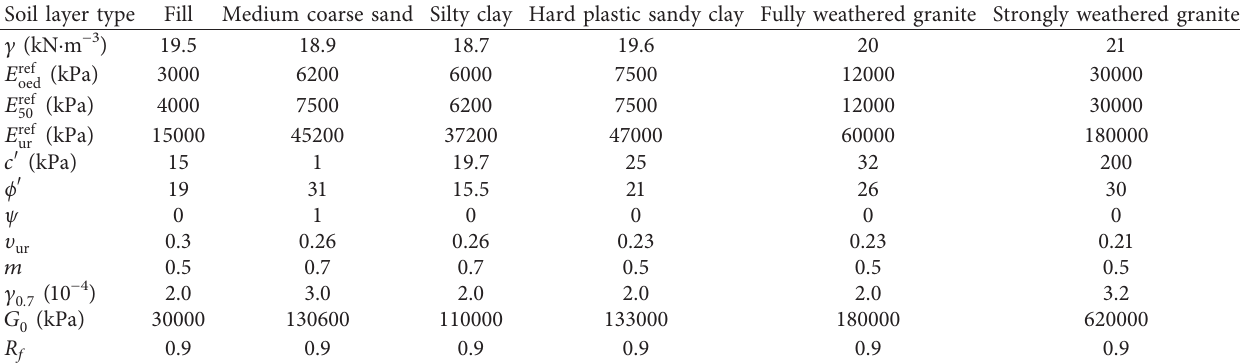
Table 3: Input values of HSS parameters.